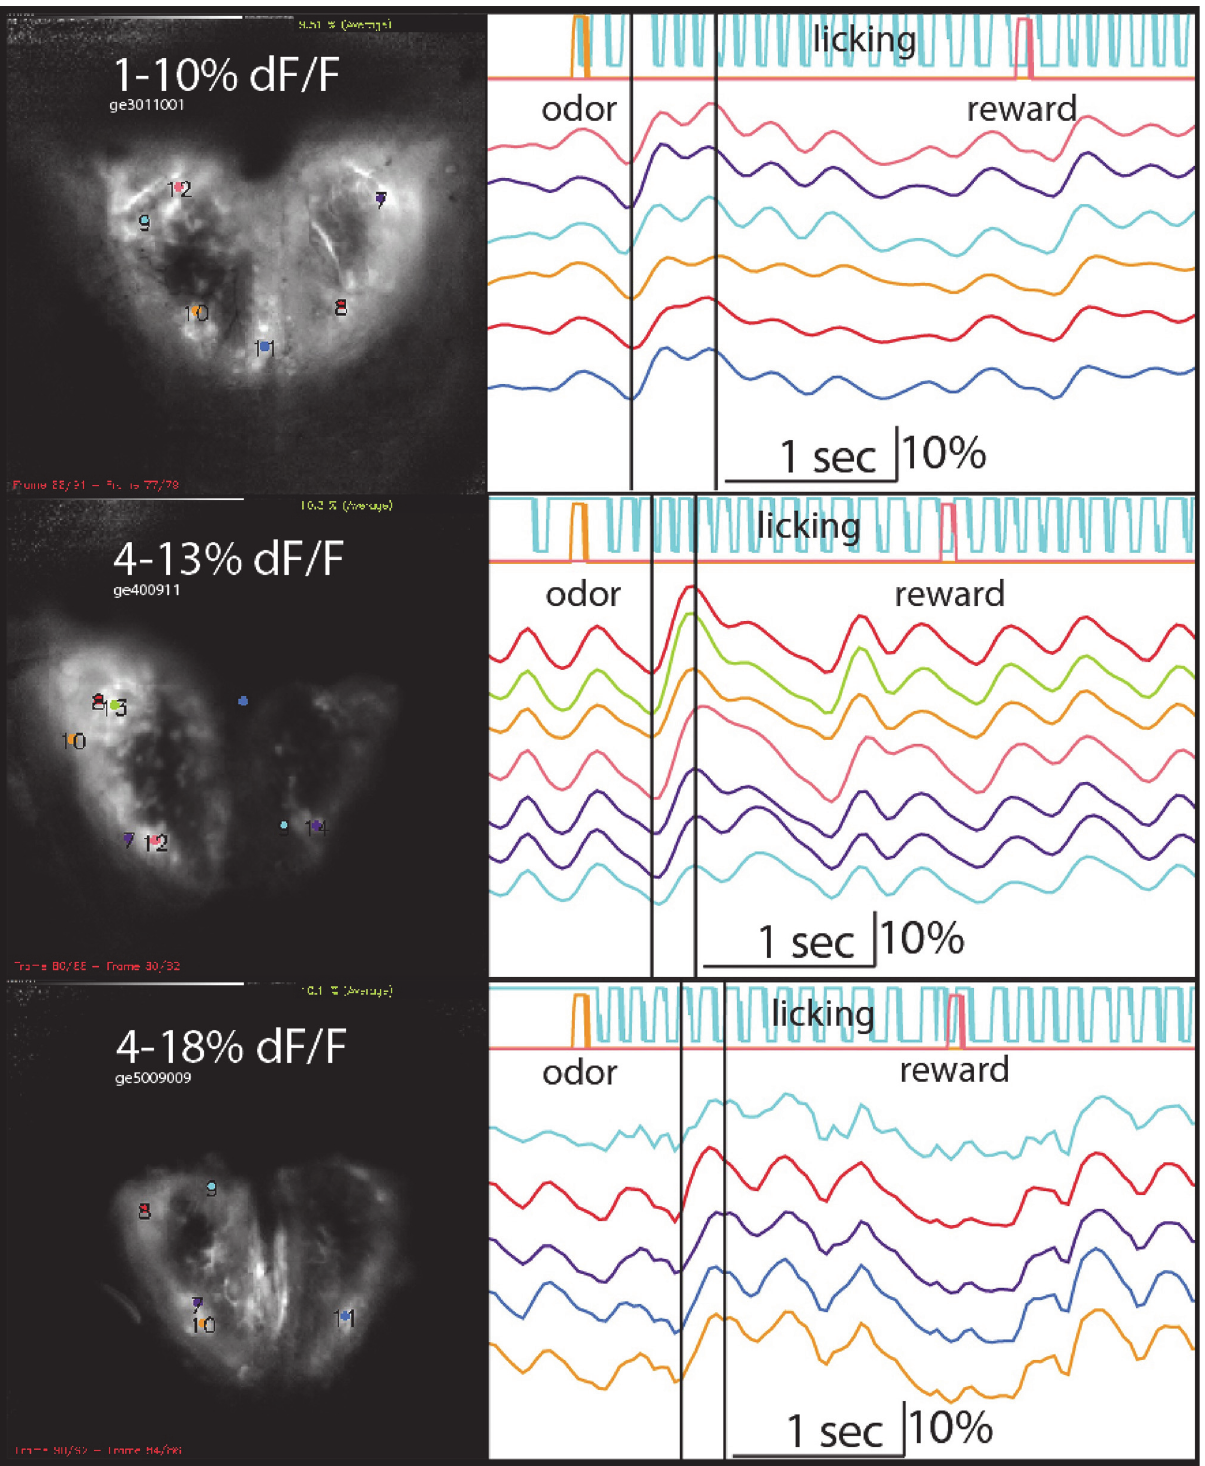
Fig 4. Optical imaging of retronasal OB responses. One trial of OB retronasal responses to 0.67% EB is shown for each of 3 GCAMP3-EMX mice (ge3, 4 and 5). Left: evoked maps and ROIs. Grey-scaling was applied between indicated minimum and maximum % Δ F/F. The OBs rostro-caudal orientation is bottom-top. Right: time-traces of ROIs, licking (blue), licked S+ odor valve open time (yellow) and water reward valve open time (pink). The two vertical lines indicate the center of the reference frames and response frames on which the response maps are based. Calibration bar: 10% Δ F/F.